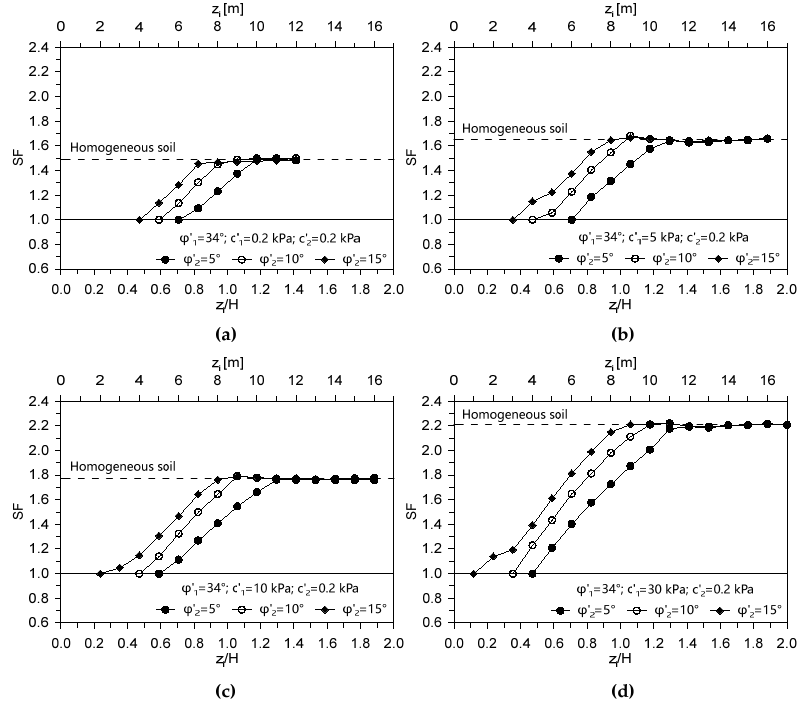
Figure 10. Safety factor SF as a function of the geometrical variable z i /H for φ′ 1 = 34° and c ′ 1 = 0.2 kPa ( a ), c ′ 1 = 5 kPa ( b ), c ′ 1 = 10 kPa ( c ) and c ′ 1 = 30 kPa ( d ), for different values of the shear strength angle φ′ 2 (5°, 10° and 15°).